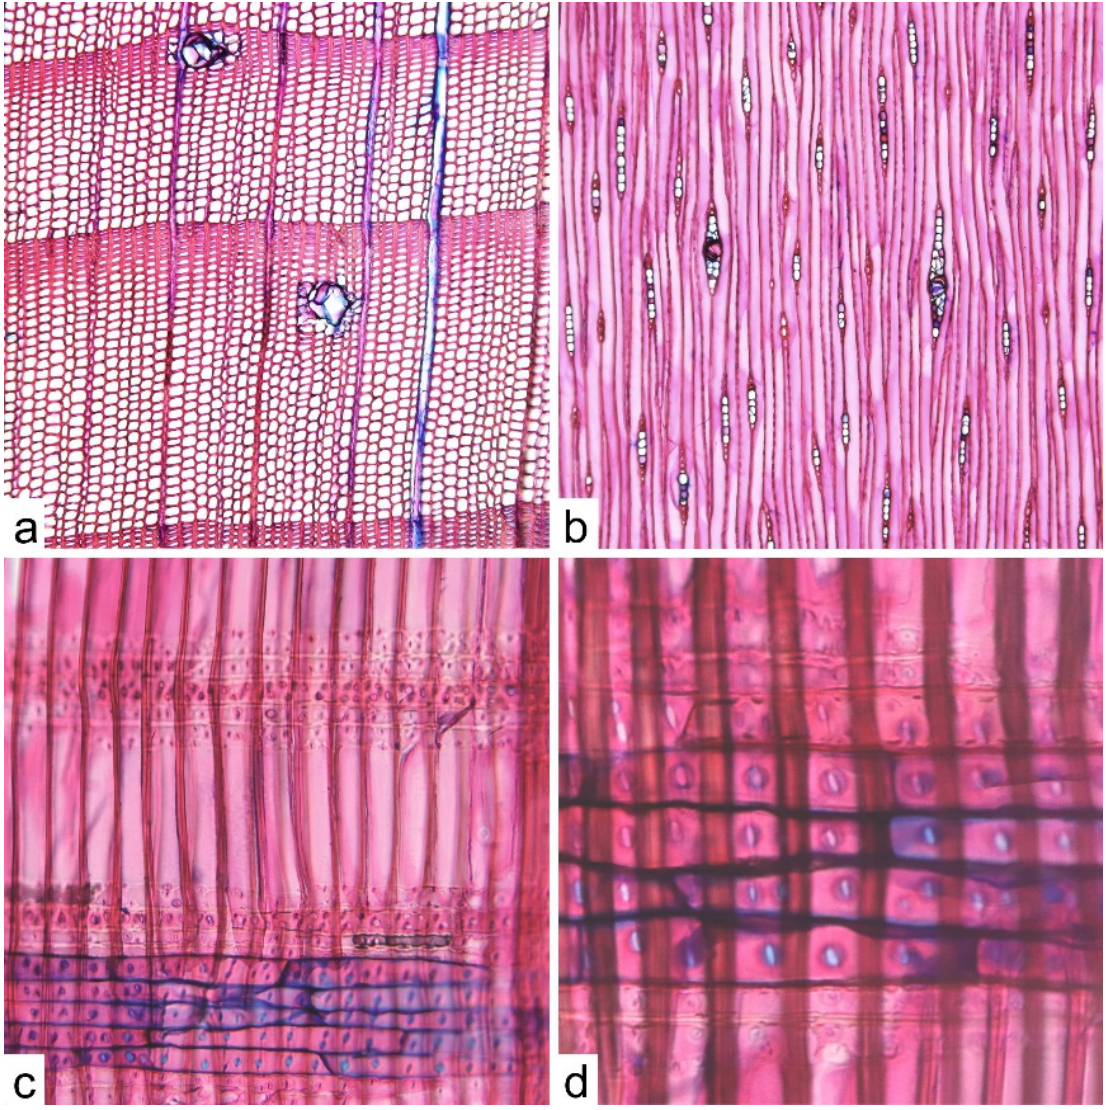
Figure 6. Bosnian pine— Pinus heldreichii , sample no. ANM0008. Microscopic slides: ( a )